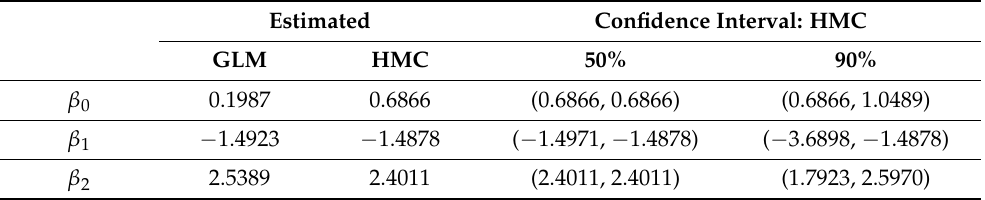
Table 4. Optimal and emotional decisions: simulation data.